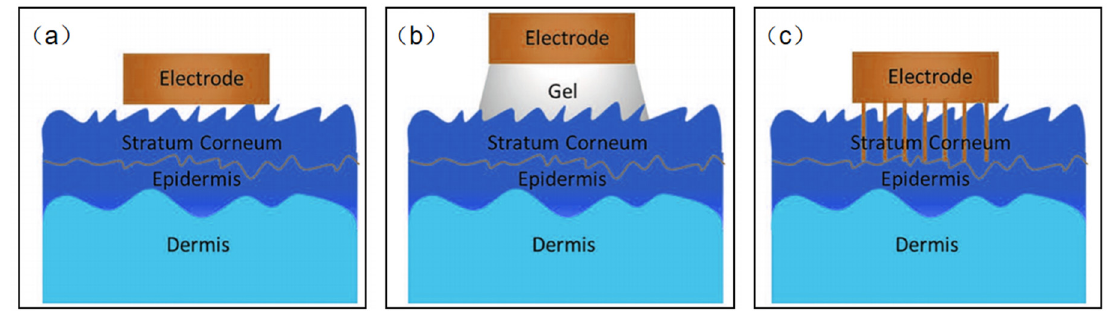
Figure 7. ( a – c ) Schematic diagram of the electrode–skin interface model.